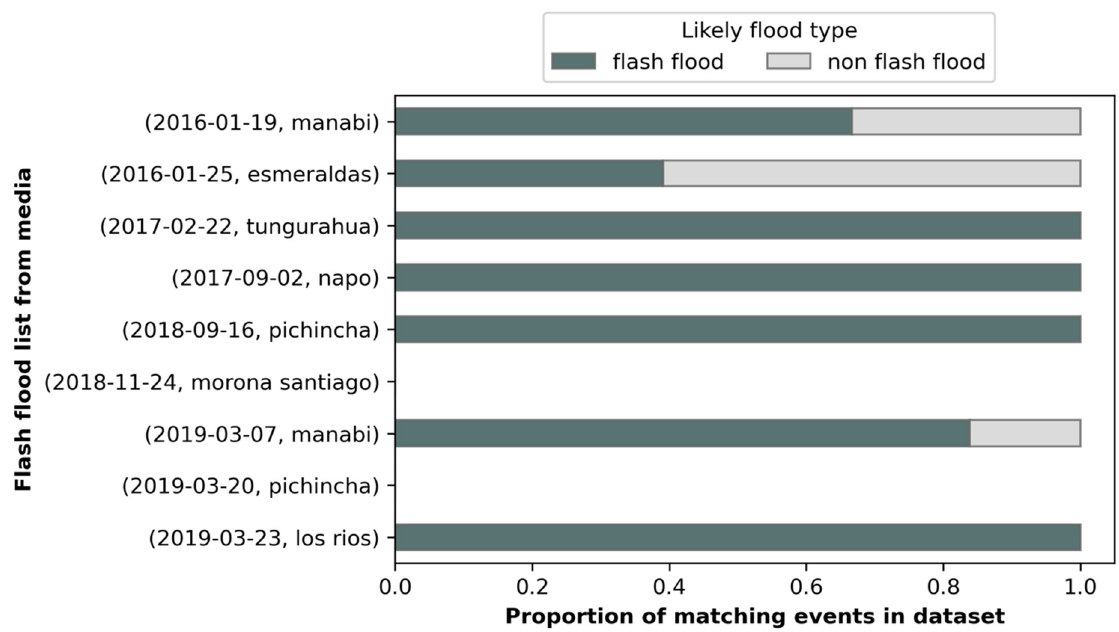
Figure 7. Proportion of likely flash flood events (eFFCI > 5) versus non likely flash flood events in our flood database matching the historical flash flood list extracted from media.